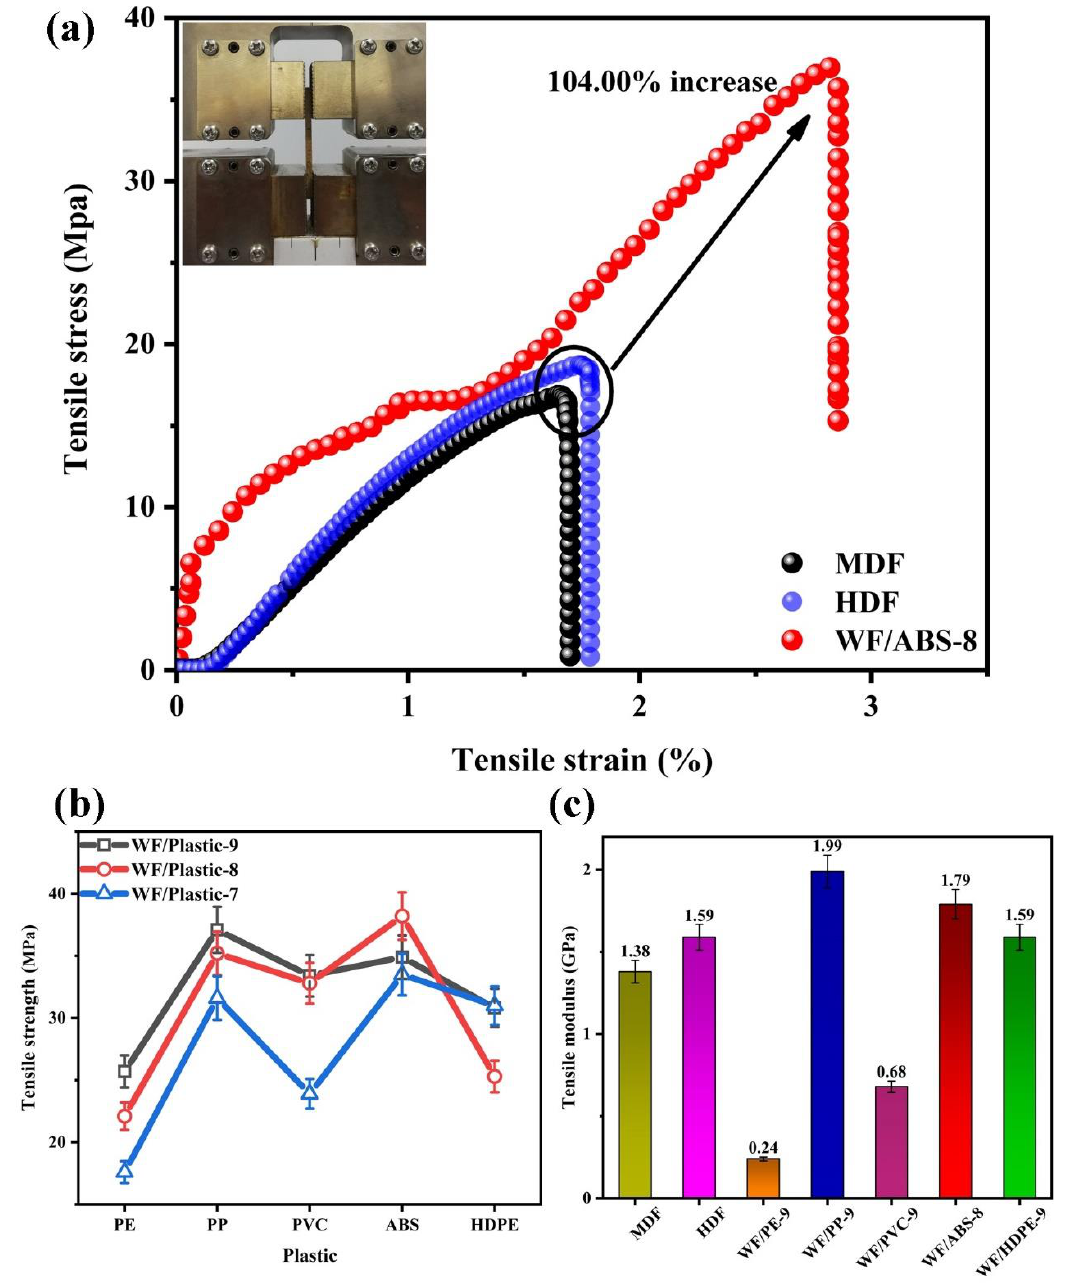
Figure 3. ( a ) Tensile stress – strain curves of WPC, MDF and HDF. ( b ) Tensile strength of WPC. ( c ) Tensile modulus of WPC.